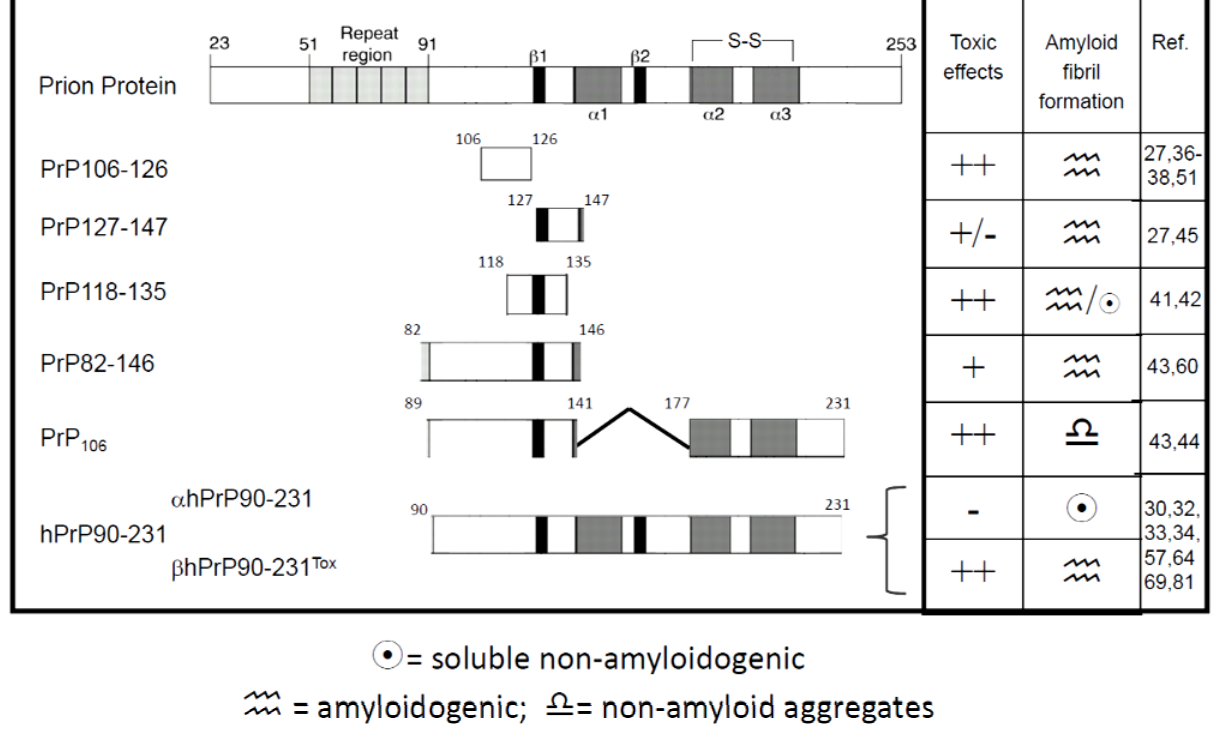
Figure 2. Schematic representation of the most commonly used synthetic and recombinant PrP peptides, and their main biophysical and biological